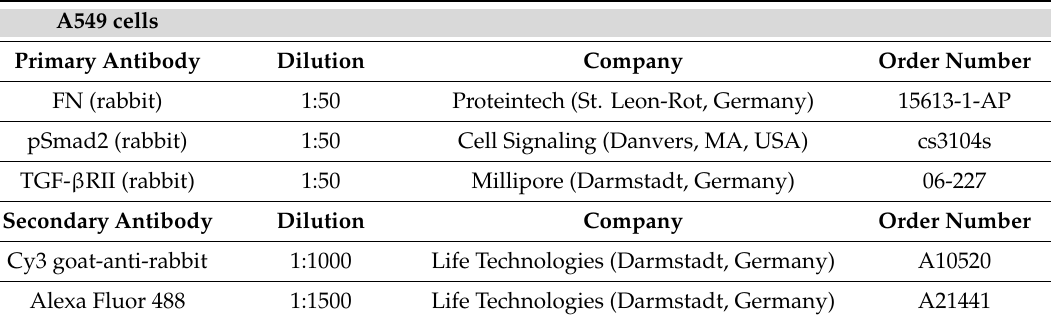
Table 4. Used antibodies for